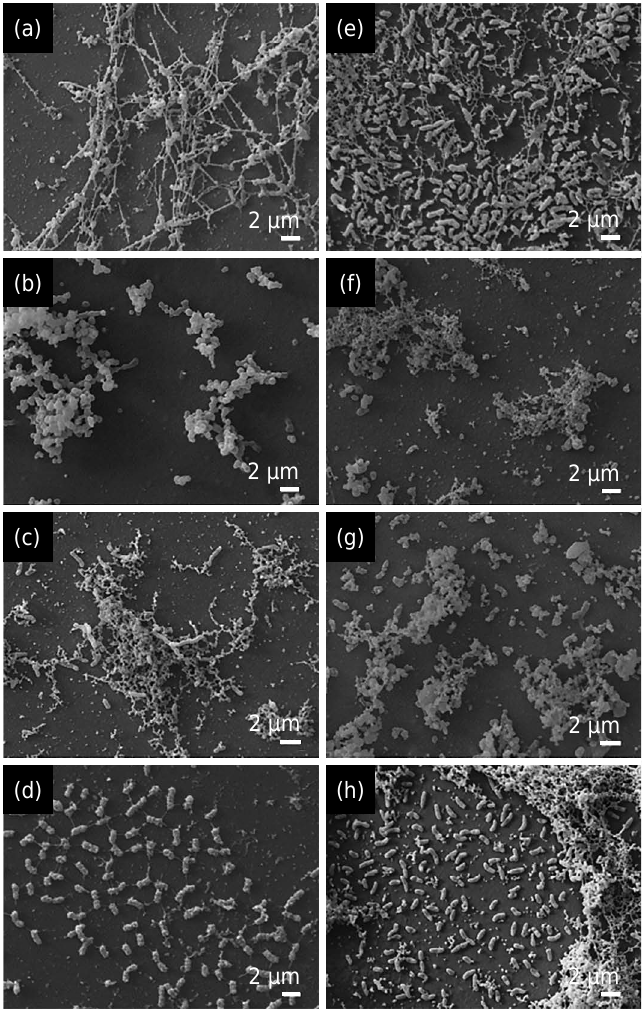
Figure 4. Scanning electron micrograph of the biomass of the strains UFLA 01-663 (a, b, c, and d) and UFLA 02-71 (e, f, g, and h) cultured in liquid LB medium in the following treatments: control - absence of metals (a and e), Cd at 1 mmol L -1 (b and f), Cu at 2 mmol L -1 (c and g), and Zn at 2 mmol L -1 (d and h).